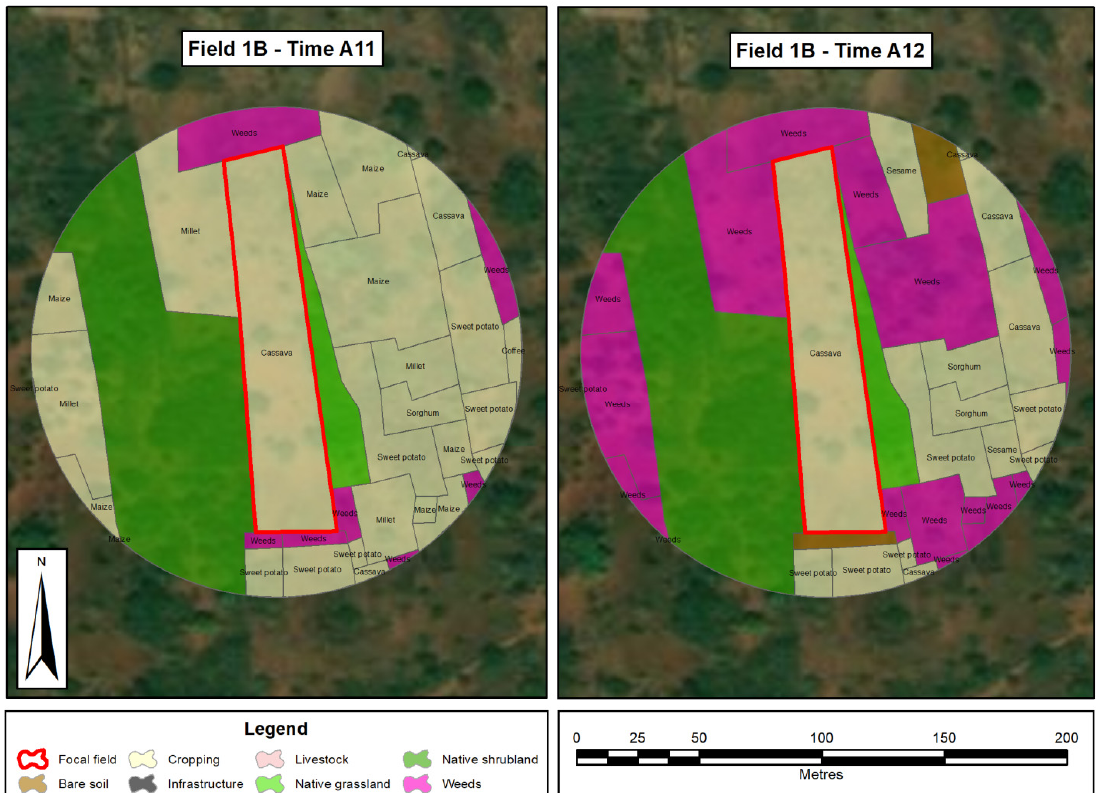
Figure 2. Land-use at a field site (1B) at time (Time A11 and at Time A12 one month later).